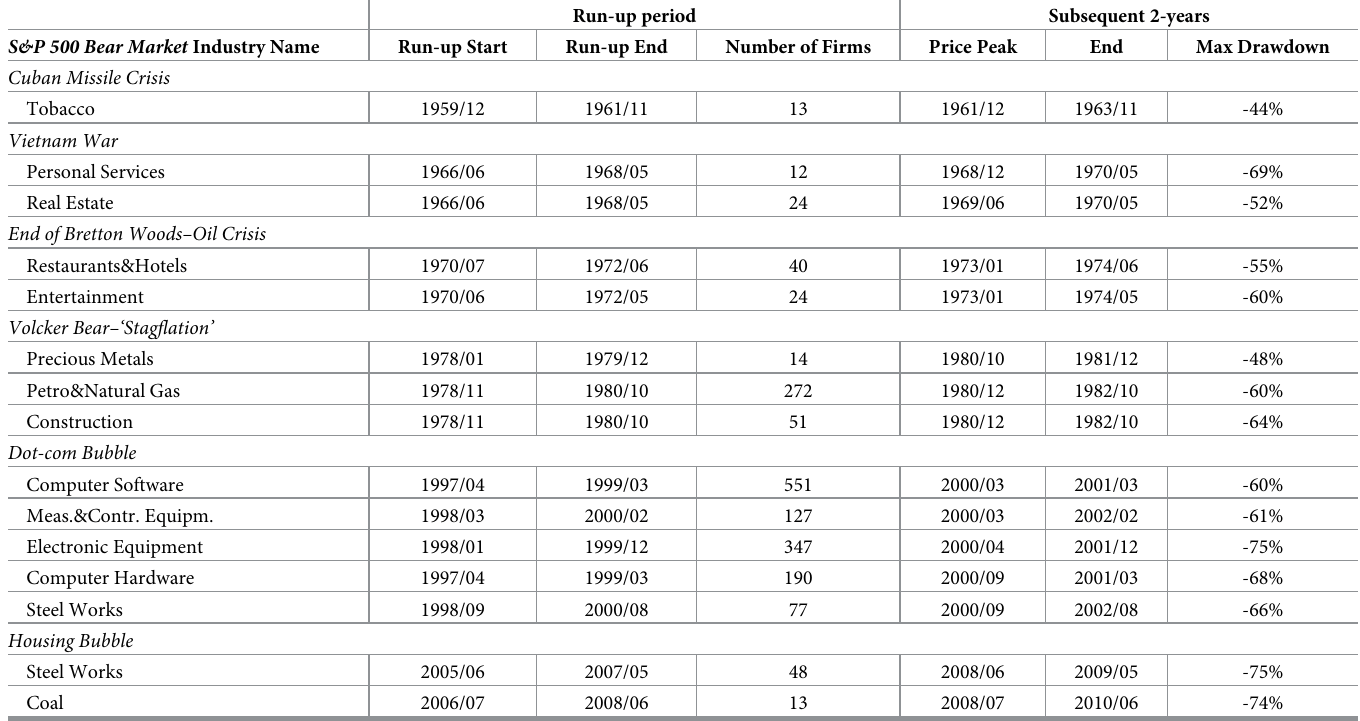
Table 1. Industry price